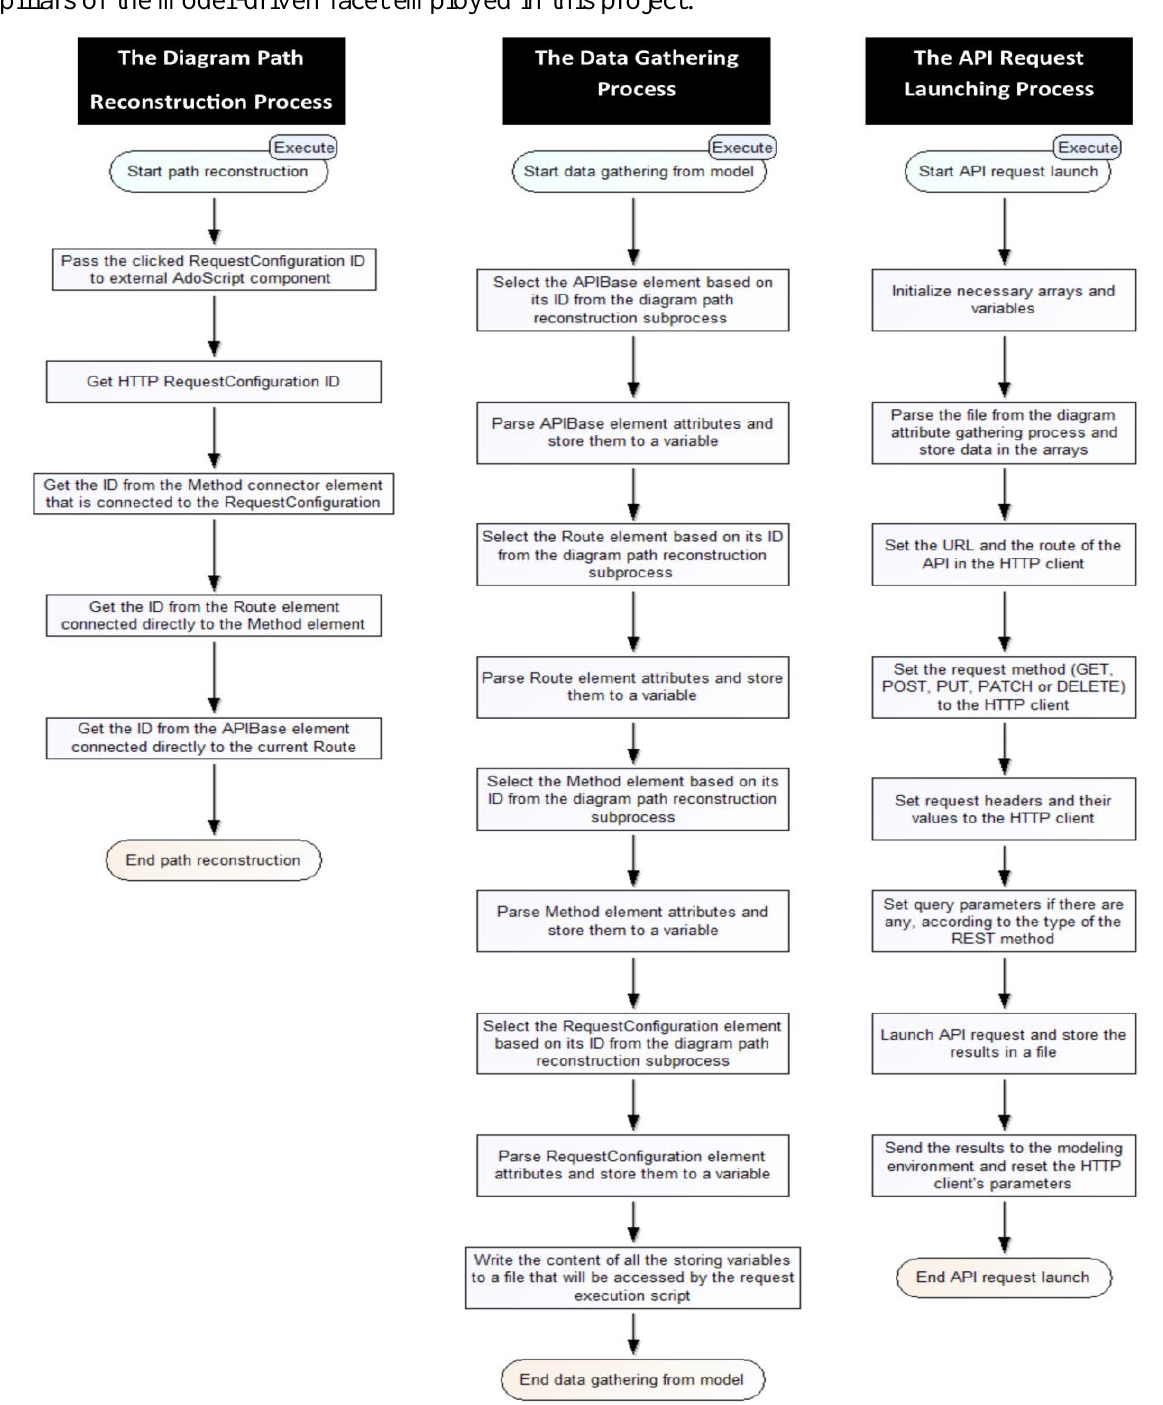
Figure 6. Flowcharts describing the diagram path reconstruction (left), the model parsing and data gathering process (center) and the API request execution process